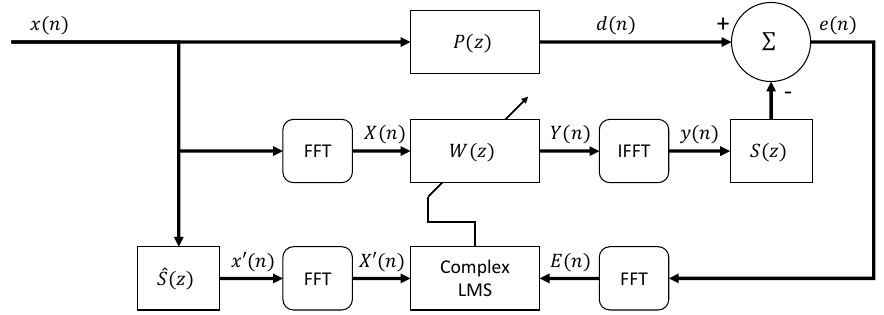
Figure 1. Frequency-domain FxLMS algorithm-based ANC system.